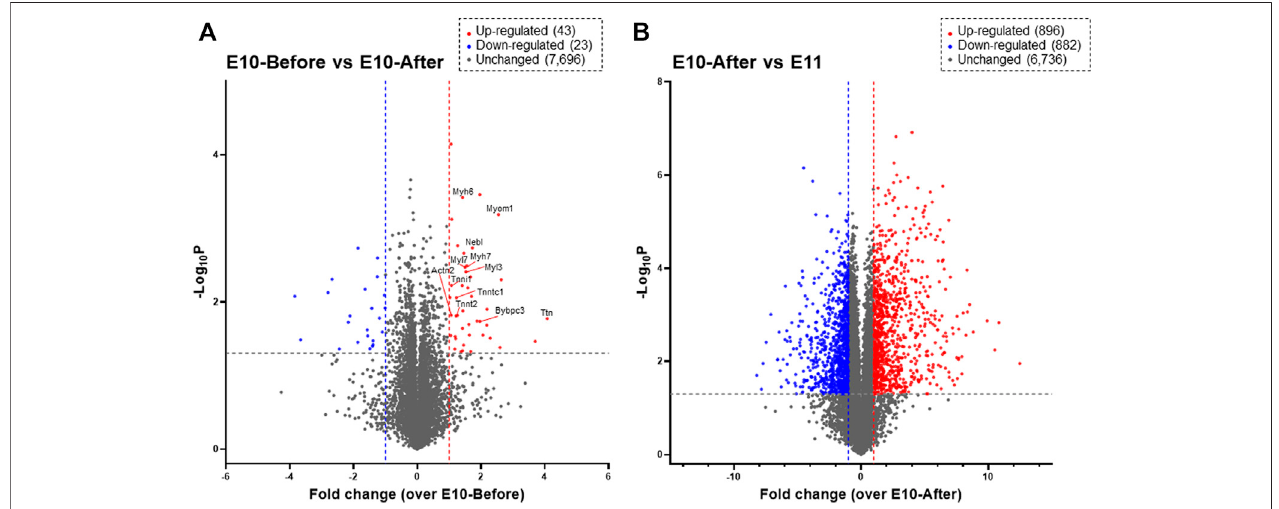
FIGURE 2 | Proteomic pro fi ling assessed by DIA-MS related to initial heartbeat in the heart primordium and to the development from the heart primordium to the primitive heart tube. Proteins that are expressed in the heart primordium before and after heartbeat initiation (A) and those expressed in the heart primordium after heartbeat initiation and the primitive heart tube (B) are shown by a volcano plot. The volcano plot represents the relationship between the magnitude ( X -axis) and statistical signi fi cance ( Y -axis) of altered protein expression. Colored plots represent expressed proteins with both a magnitude of change of more than 2.0 fold (Red: upregulated, Blue: downregulated) and signi fi cant change ( p value < 0.05).